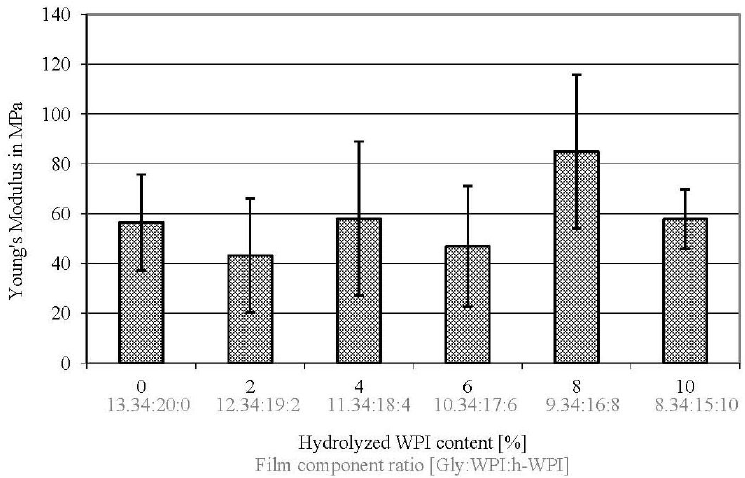
Figure 5. Effect of increased h-WPI content (reduced protein M content on the Young’s Modulus values of WPI-based